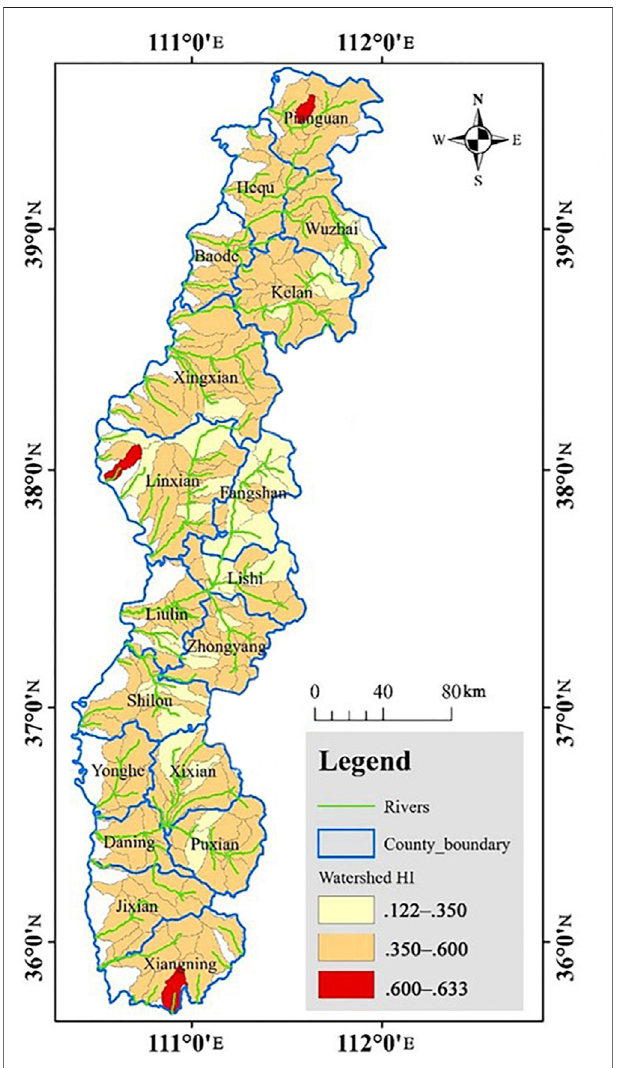
FIGURE 6 | Map of the spatial differentiation of the hypsometric integral (HI) of the watershed based on the Strahler watershed classi fi cation method.